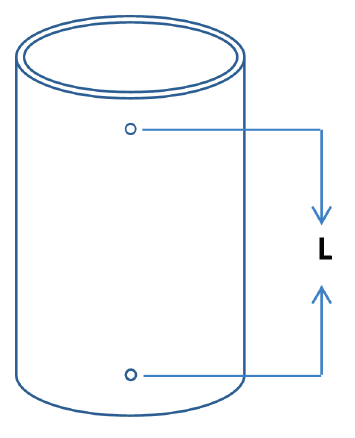
Figure 1. Schematic of the hollow cylinder specimen made by laser